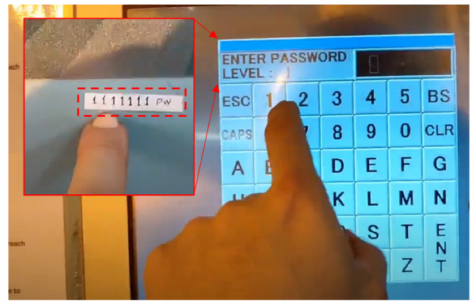
Figure 2. BWMS password exposure via SNS images of the